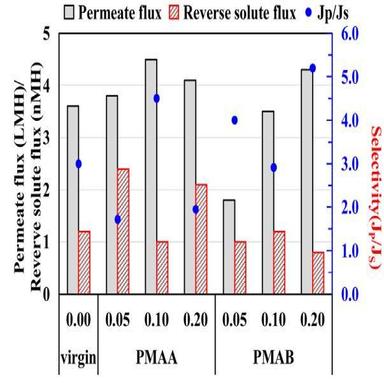
FO performance of the TFC and TFN membranes of PMA, PMAA, and PMAB with different dosages (%).